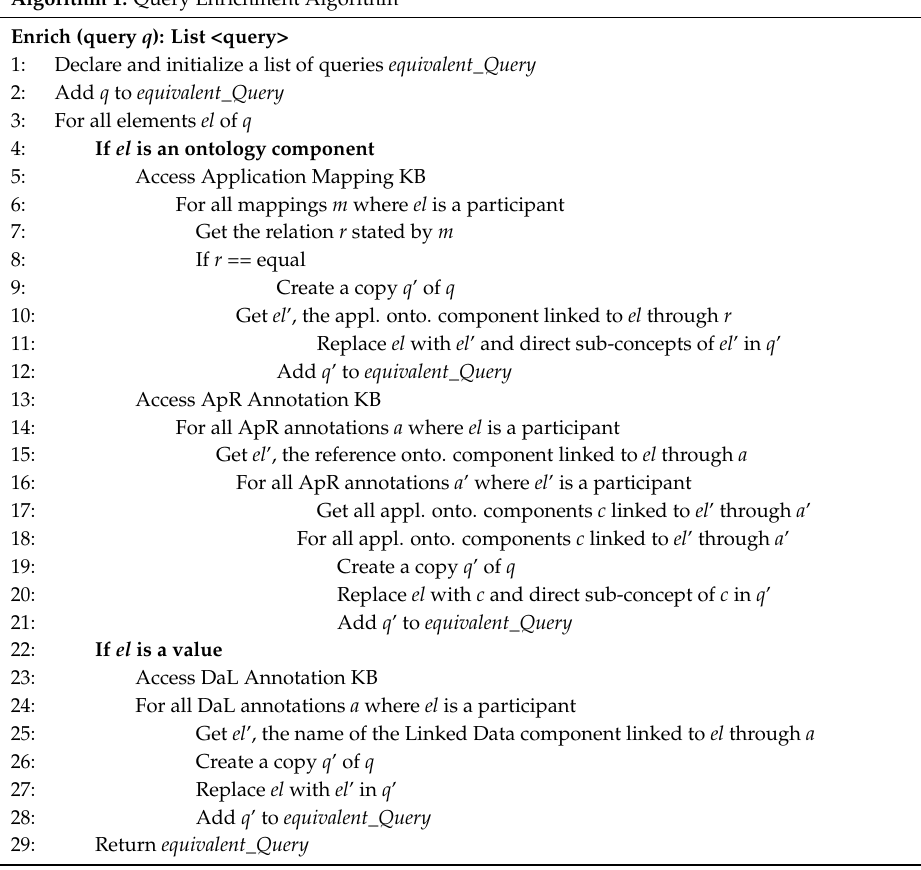
Algorithm 1. Query Enrichment